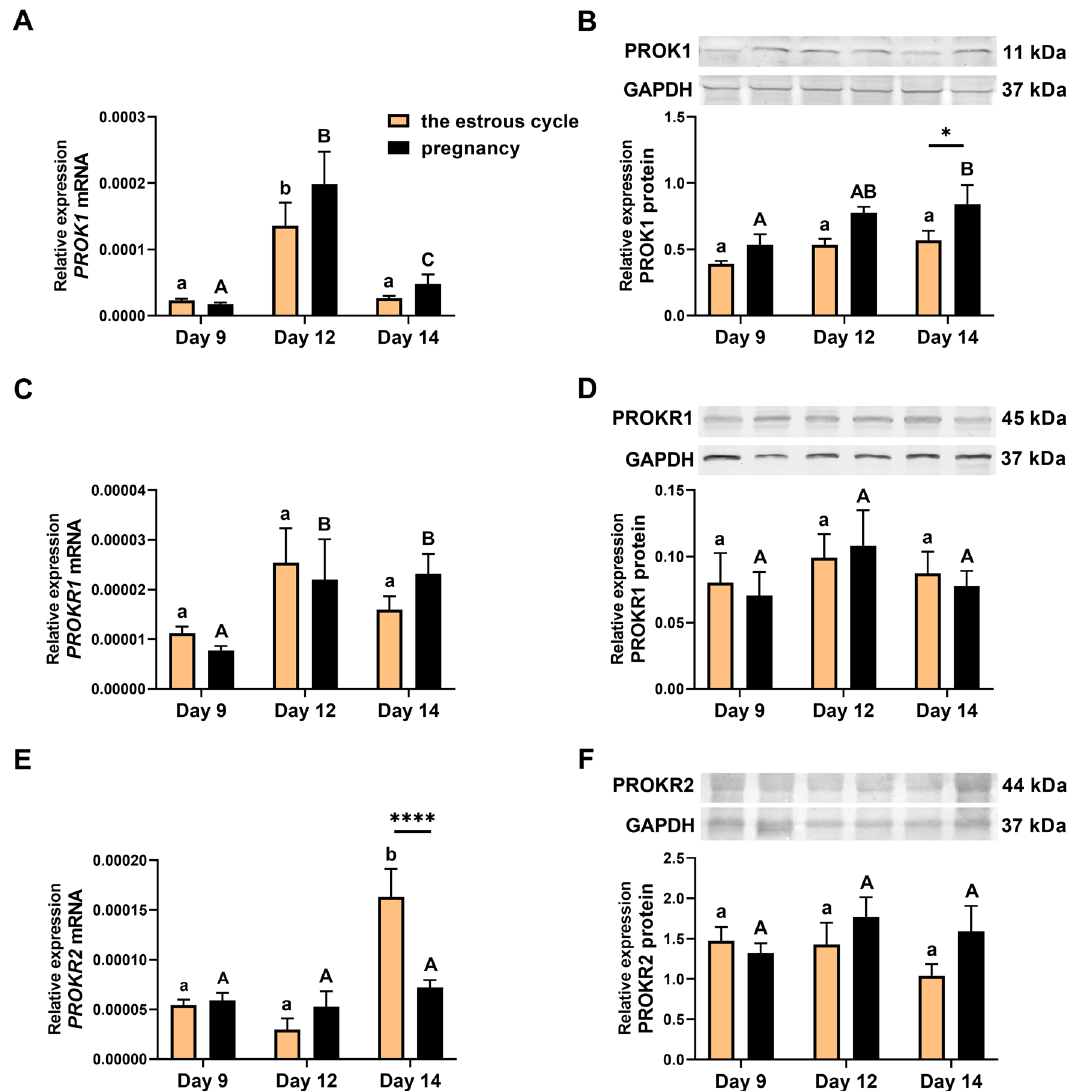
Figure 1. The expression profiles of prokineticin 1 (PROK1; A and B ), prokineticin receptor 1 (PROKR1; C and D ) and 2 (PROKR2; E and F ) mRNA ( A , C , and E ) and protein ( B , D , and F ) in the porcine corpora lutea on Days 9, 12, and 14 of pregnancy and the estrous cycle. Representative samples of Western blots are shown in the upper panels ( B , D , F ). Uncropped images of full length Western blot membranes are shown in Supplementary Fig. 2. Data are presented as means ± SEM. Bars with different letters differ significantly ( p < 0.05) within the estrous cycle (lowercase letters) and pregnancy (capital letters). Asterisks indicate statistical differences between reproductive statuses (pregnant vs. cyclic) on corresponding day of the estrous cycle and pregnancy (* p < 0.05; *** p < in medium from luteal explants collected on Day 12 of pregnancy ( p < 0.05), Day 14 of the estrous cycle ( p < 0.05), and Day 14 of pregnancy ( p < 0.01; Fig. 3D). The stimulating effects of PROK1 were abolished by a PROKR1 antagonist (PC7). The P4 concentration (mean ± SEM) in the control medium was 1717 ng/mL ± 121 on Day 12 of the estrous cycle, 1347 ng/mL ± 182 on Day 12 of pregnancy, 1314 ng/mL ± 219 on Day 14 of the estrous cycle, and 1621 ng/mL ± 213 on Day 14 of pregnancy. To determine the effects of the incubation time and treatment on the viability of the luteal slices, an Alamar Blue assay was performed. The metabolic activity of CL explants was not significantly different between 0 and 18 h of incubation (100 ± 7.29% vs. 91.32 ± 0.87%). In addition, none of the treatments used decreased the tissue explant viability after 18 h of incubation compared to the control (Fig. 4). The antagonist for PROKR1 alone or in combination with PROK1 did not have any effect on tissue explant viability. However, PROK1 slightly increased